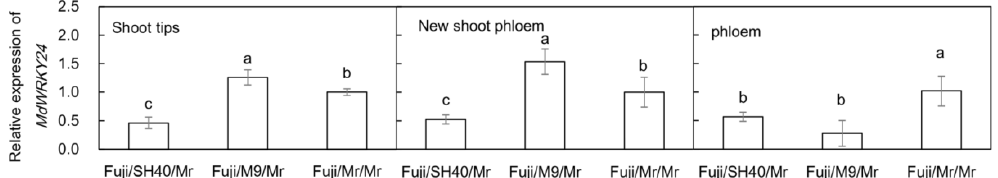
Figure 7. Expression of MdWRKY24 gene in different parts for the three stock and scion combinations. Lowercase letters indicate significant differences.